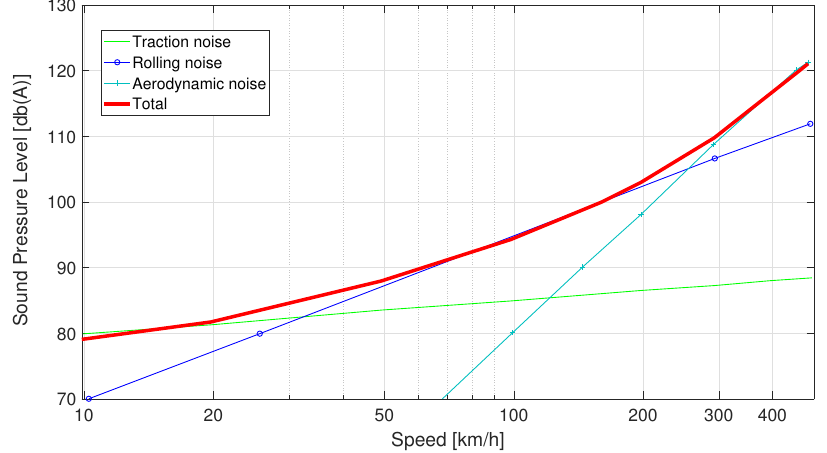
Figure 1. Evolution of the contribution of the different sources according to the speed of circulation (adapted from